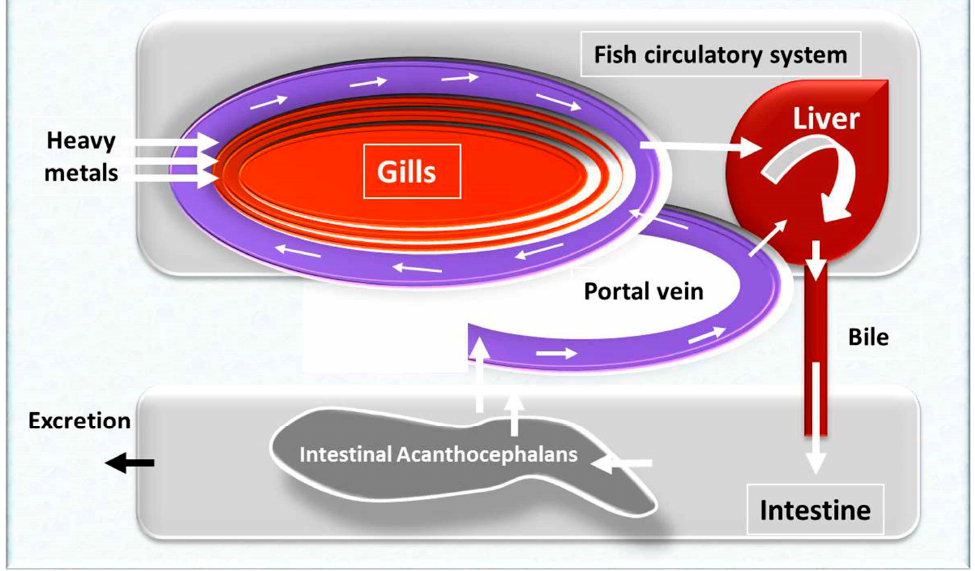
Figure 3. The uptake, transport and excretion of heavy metals in fish, and the route of metal uptake through the intestinal parasite such as acanthocephalans.